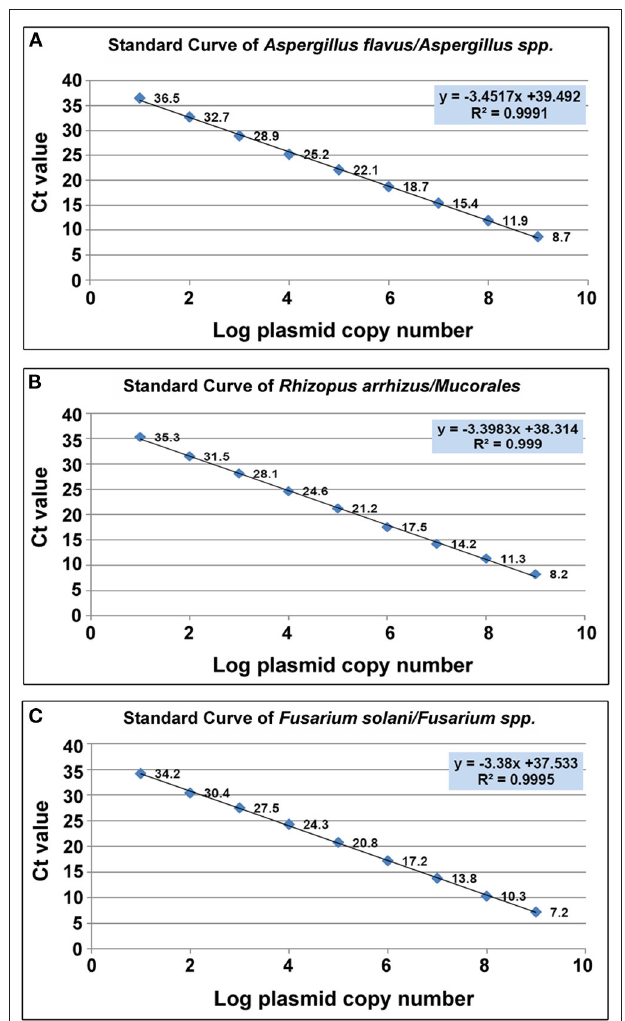
FIGURE 3 | Scatter plot of CT value vis Log plasmid copy number. (A) Aspergillus spp (A.flavus). (B) Mucorales. (R.arrhizus) (C) Fusarium spp . (F.solani)